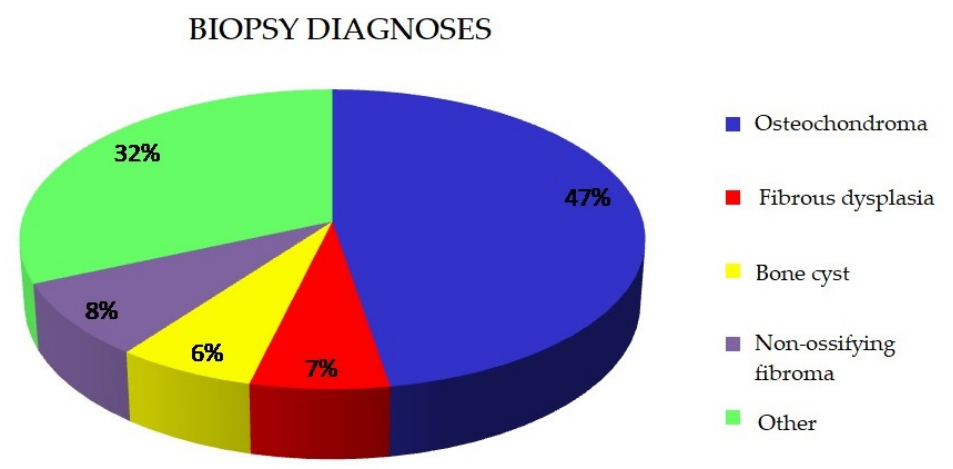
Figure 2. Biopsy diagnoses.